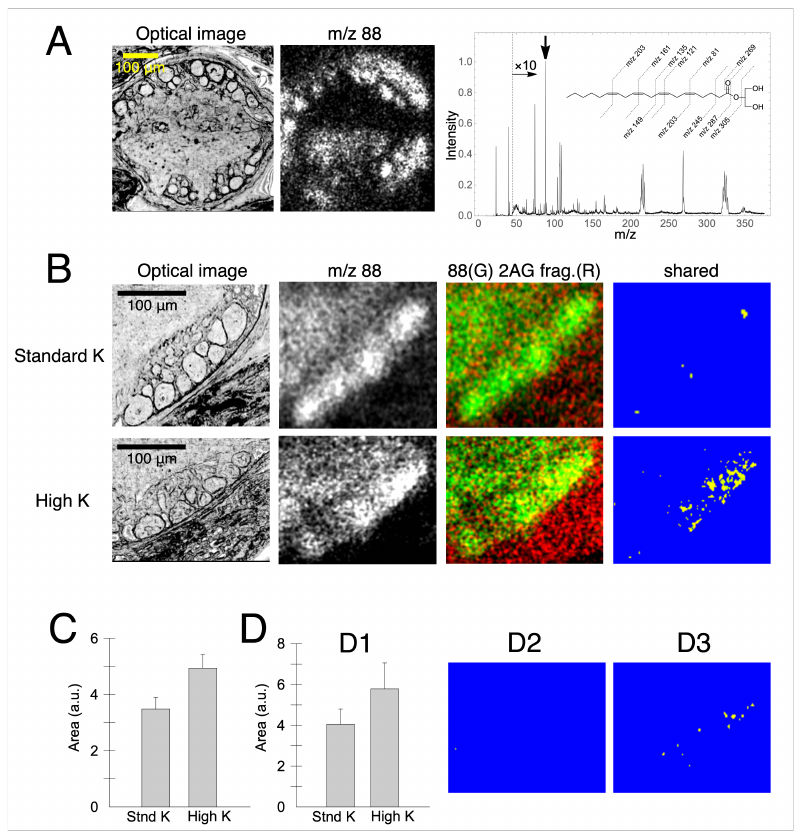
Figure 4. Neuronal localization of putative 2-AG. ( A ) Unstained optical image of a somatic ganglion ( left ) and an image of m / z 88 ( right ). m / z 88 is pointed by an arrow in the mass spectrum. Fragments of 2AG are depicted above the spectrum. ( B ) Images of 2-AGfragSum (red) and m / z 88 (green) in a standard concentration (3 mM) of potassium (K) (in the upper set of data) and those in a high concentration (30 mM) of K (in the lower set of data). Yellow segments represent the colocalization of 2-AGfragSum (red) and m / z 88 (green). ( C ) A summary graph indicating an increased localization of putative 2-AG in high K-treated neurons (student t -test, t = 2.358, p = 0.027, N = 12 ganglia in each experiment). ( D ) Colocalization of m / z 40 (likely calcium) and m / z 88. ( D1 ) A subtle increase of m / z 40 in high K-treated neurons (student t -test, t = 1.157, p = 0.274, N = 6 in each experiment). ( D2 , D3 ) Yellow ROIs indicated calcium images in neurons treated with a standard K vs. high K,